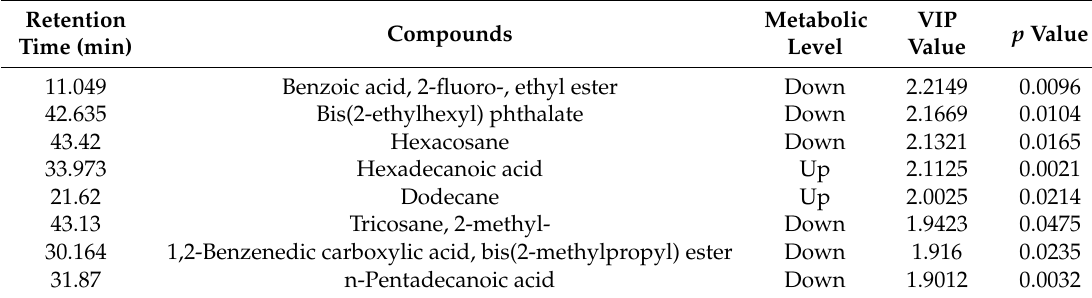
Table 1. The differently abundant metabolites from HN48 root tissue under different continuous- cropped year soil in potted-experiments.